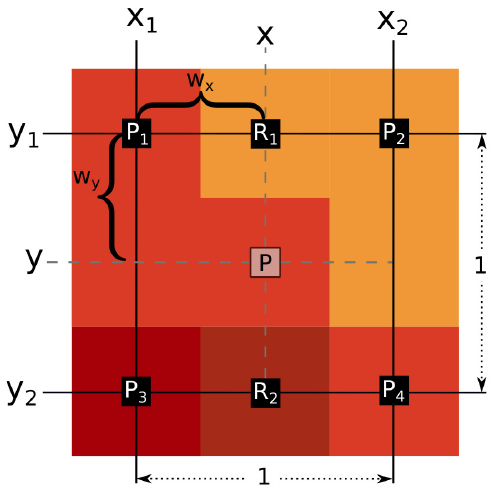
Figure 6. Normalized weighting bilinear interpolation